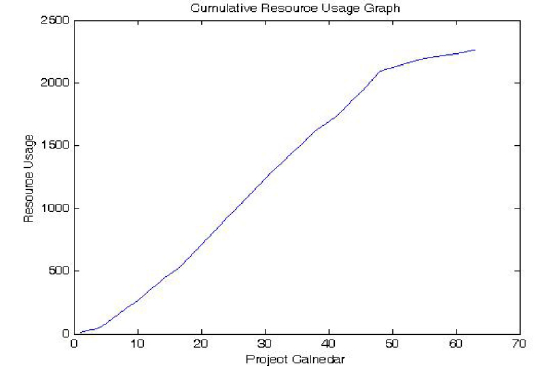
Figure 36. Cumulative resource usage for resource 1 of experiment 3 (relaxed resource constraint)